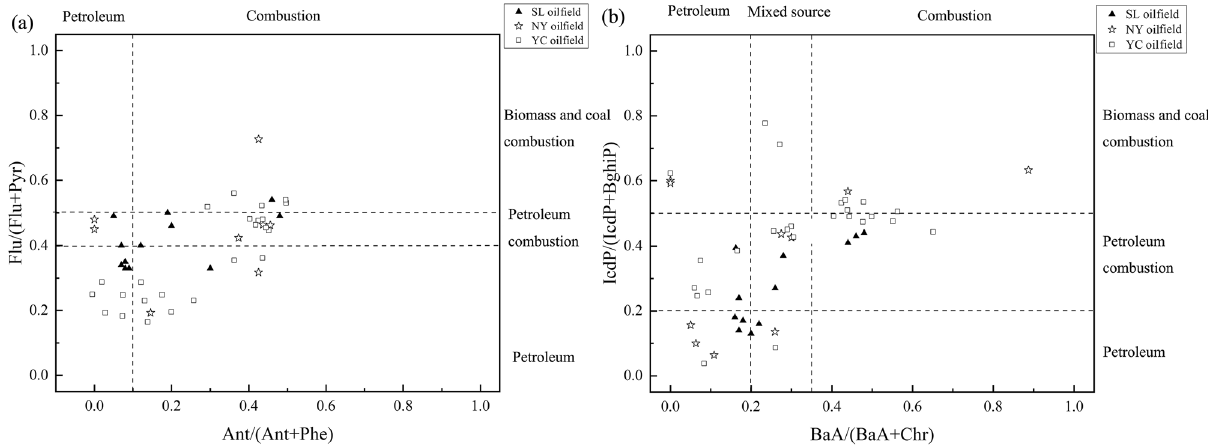
Figure 6. Diagnostic ratio for analysis in source of PAHs in three oilfield soils. ( a ) ratios plot of Flu/(Flu + Pyr) and Ant/ (Ant + Phe); ( b ) ratios plot of IcdP/(IcdP + BghiP) and BaA/(BaA +